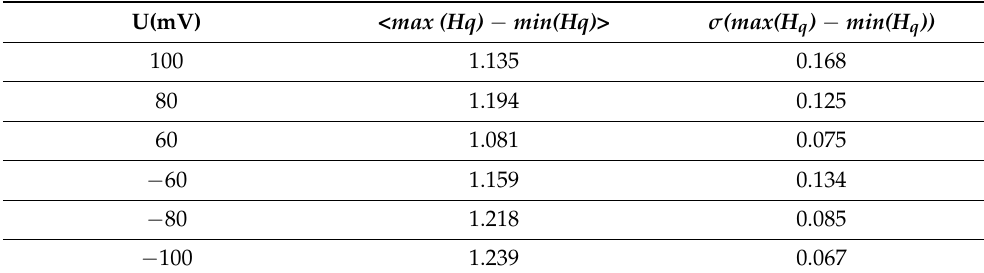
Table 1. The mean value and standard deviation of the singularity spectrum width with respect to the external